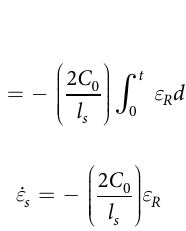
Figure 3. Three-dimensional FE model in Abaqus 6.13 software (Dassault System, Simulia Corp, USA). ( A ) Micro-CT images of femoral condyle of rabbit. ( B ) 3D solid structure of bone tissue. ( C ) Tie-constraint between the implant and bone tissue. ( D ) Boundary condition of the model. ( E ) Simulation model under impact loading at 0°, 45°, and 90° along the axis of the